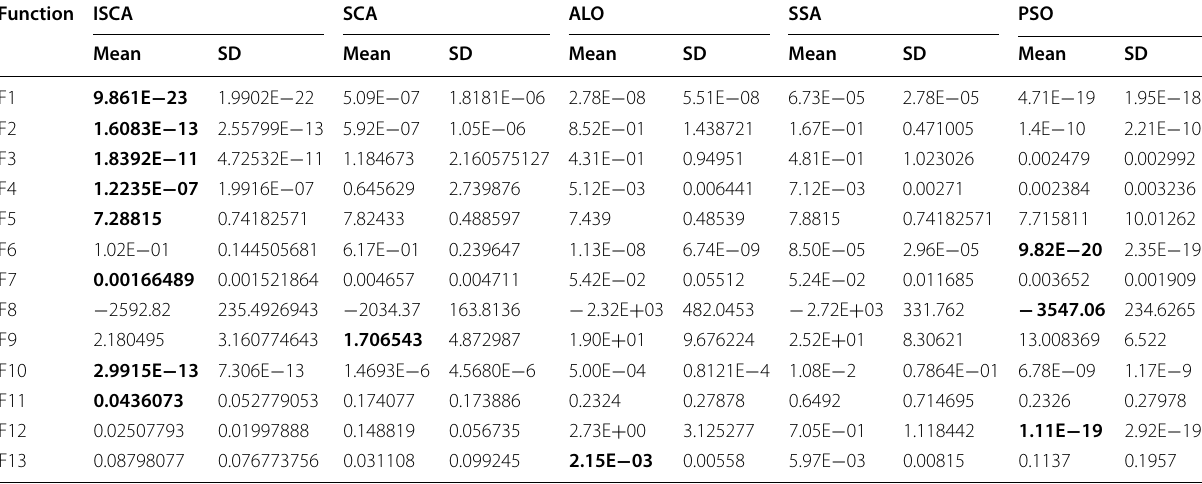
Table 1 Performance evaluation of ISCA over SCA, SSA, ALO, and PSO with the results of unimodal and multimodal benchmark test function Function ISCA SCA